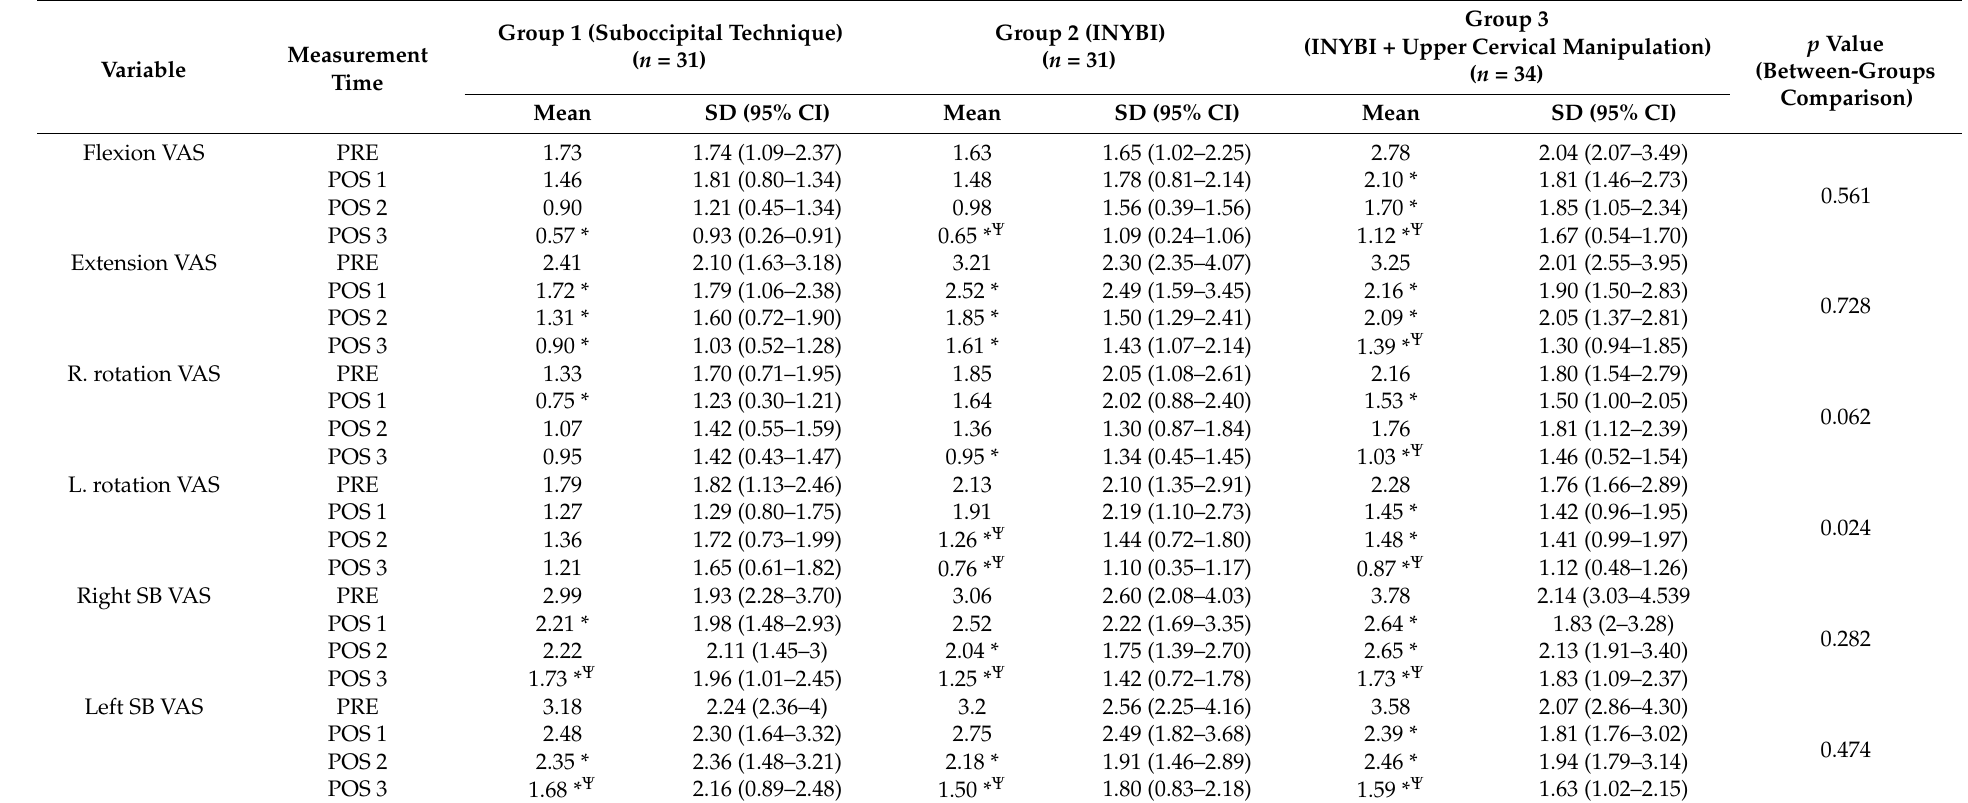
Table 3. PRE and POST VAS